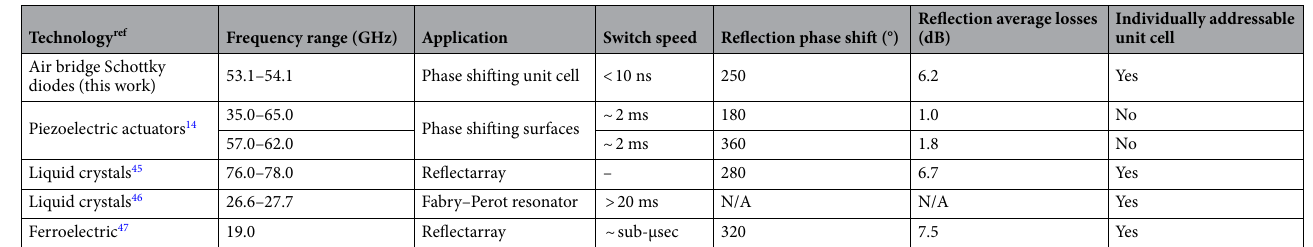
Table 4. The performance characteristics of the most well-known V-band tuning methods when used in periodic metasurface based structures. Indicative values for the main operating characteristics such as